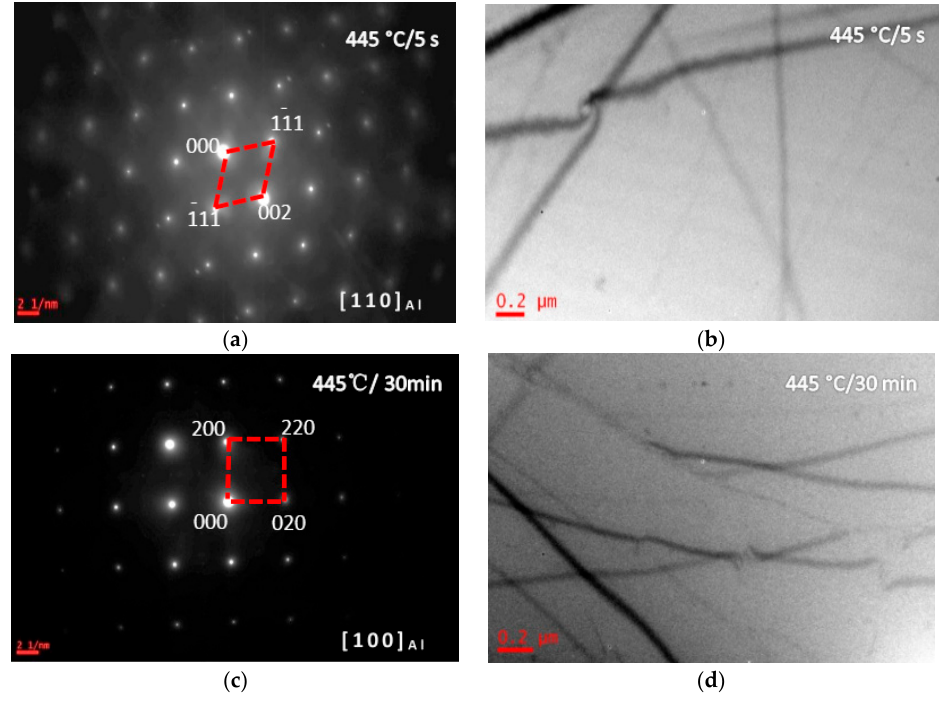
Figure 5. SADPs and BF images of the studied alloy having been isothermal heat treated at 445 °C for 5 s and 30 min. ( a ) SADP from the area in (b); ( b ) the isothermal heat treatment time is 5 s; ( c ) SADP from the area in (d); and ( d ) BF image, the isothermal heat treatment time is 30 min.